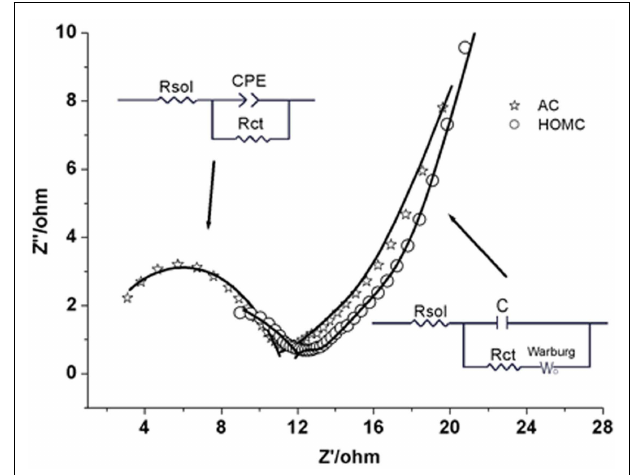
FIGURE 6 |AC impedance spectra for HOMC ( (cid:13) ) andAC ( ) in 30% KOH solution . Insets are the equivalent circuits used for the fitting of the AC impedance spectrum.The equivalent circuit on the left was used to fit the spectrum in the frequency range of 100kHz to 1Hz and the one on the right was used for the frequency range of